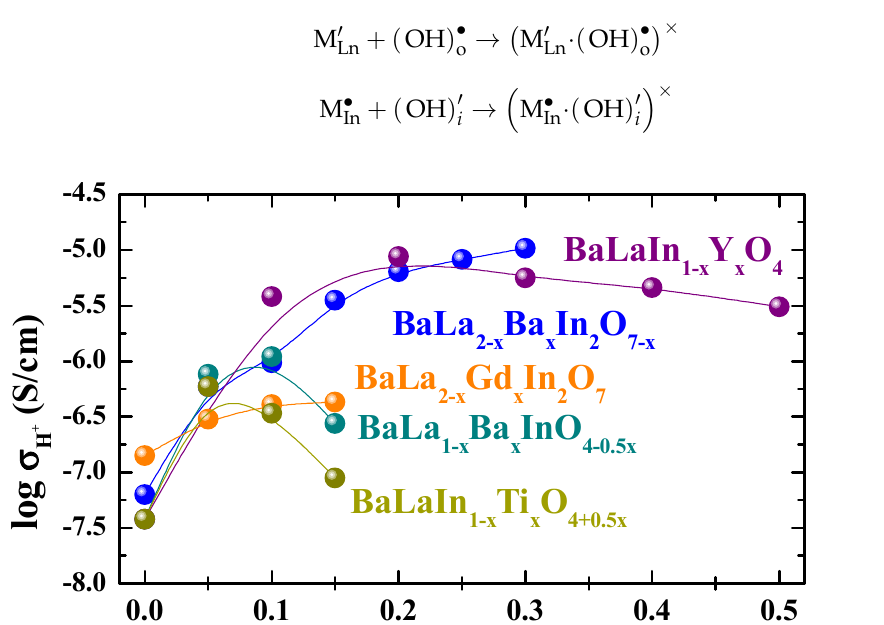
Figure 8. The concentration dependencies of protonic conductivities for heterovalent-doped BaLa 1– х Ba x InO 4–0.5 х [76], BaLaIn 1– х Ti x O 4+0.5 х [78], BaLa 2– х Ba x In 2 O 7– х [86] and isovalent-doped BaLaIn 1 − x Y x O 4 [80], BaLa 2– x Gd x In 2 O 7 [90] compositions at 300 °C.